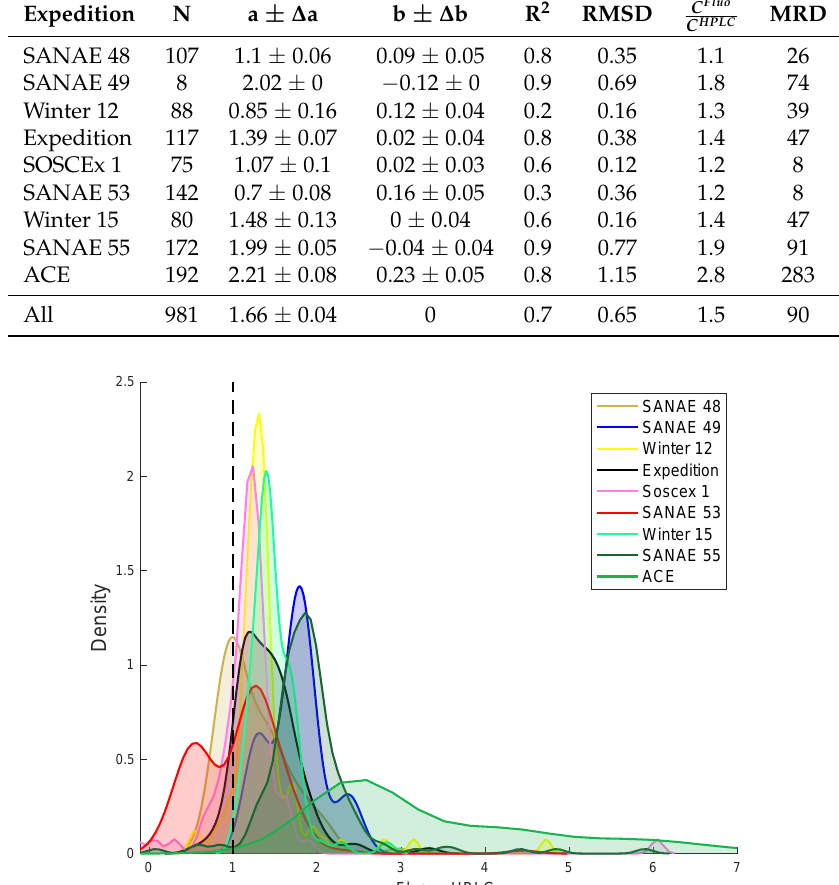
Table 4. Statistics of the relation between chlorophyll-a measured from HPLC and fluorometry for each expedition. The number of observations (N), the slope (a), the intercept (b) and their standard deviations ( ∆ a and ∆ b) and coefficients of determination (R 2 ) of the linear regression are indicated. RMSD is the root mean square difference and MRD is the mean relative difference (see Section 2.3 for formulations).